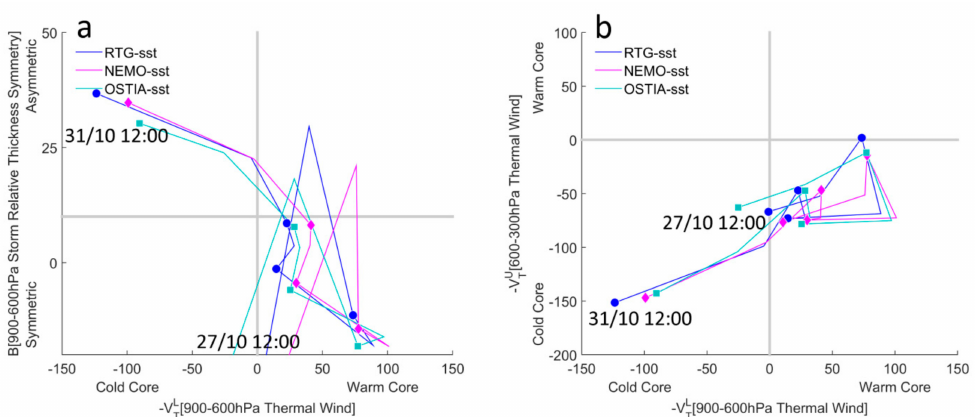
Figure 9. Phase space diagrams of ( a ) − V L vs. − V U (600–300 hPa) evolution from RTG-sst, NEMO-sst, and OSTIA-sst simulations during cyclone T Trixi. Markers are shown every 12:00 UTC.